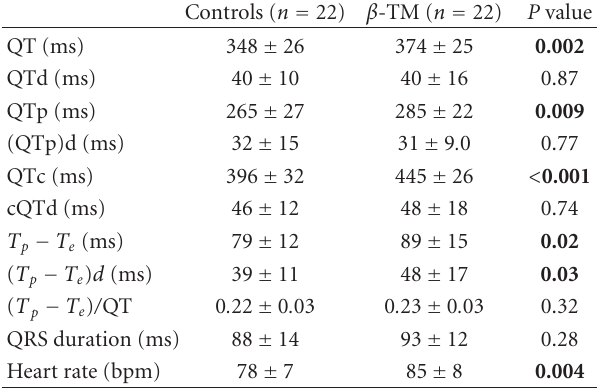
Table 2: Electrocardiographic parameters of the β -TM group and